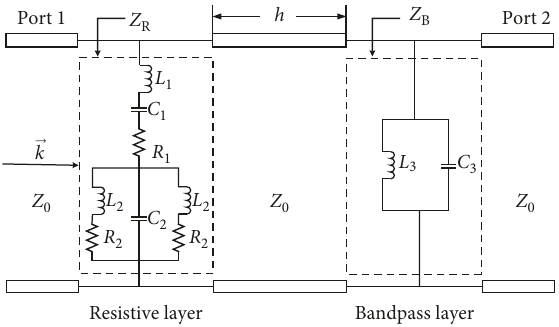
Figure 1: Equivalent circuit